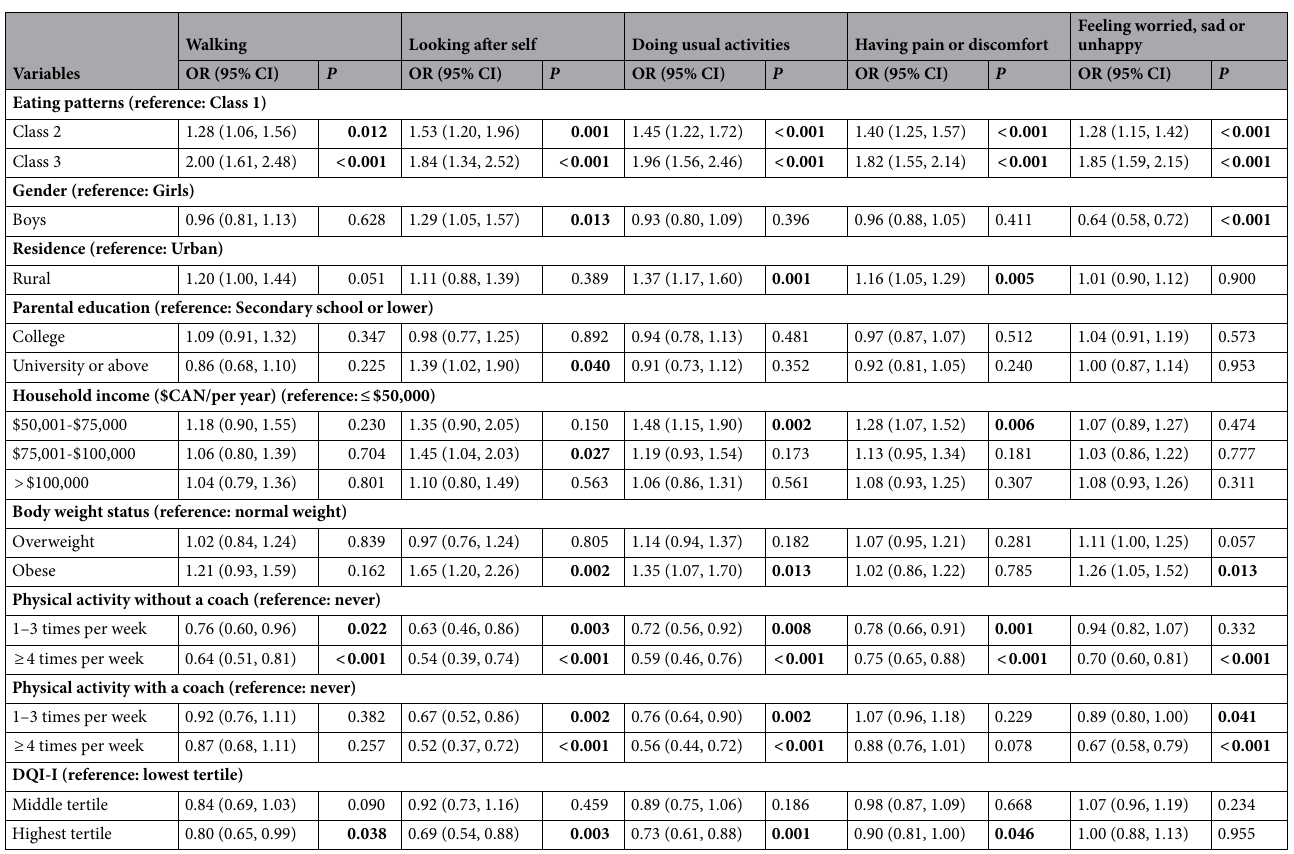
Table 4. The odds of reporting some or a lot of problems in the EQ-5D-Y dimensions by the eating patterns, grade five students participating in the 2008, 2010 and 2012 Real Kids Alberta surveys in Canada. P : p value; bold p values indicate a statistically significance (p < 0.05). The regression model for each EQ-5D-Y dimension adjusted for children’ gender, residency, highest level of parental education, household income, body weight status, PA and diet quality. OR odds ratio, CI confidence